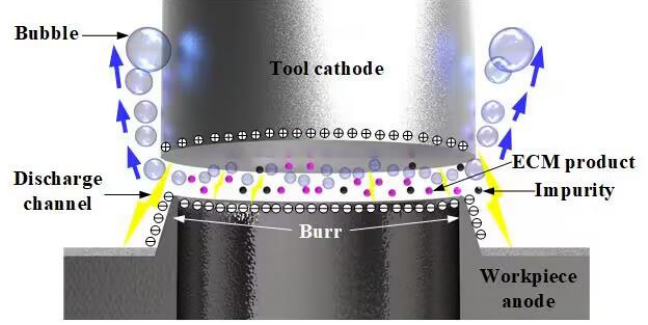
Figure 1. Principle of electrochemical deburring.